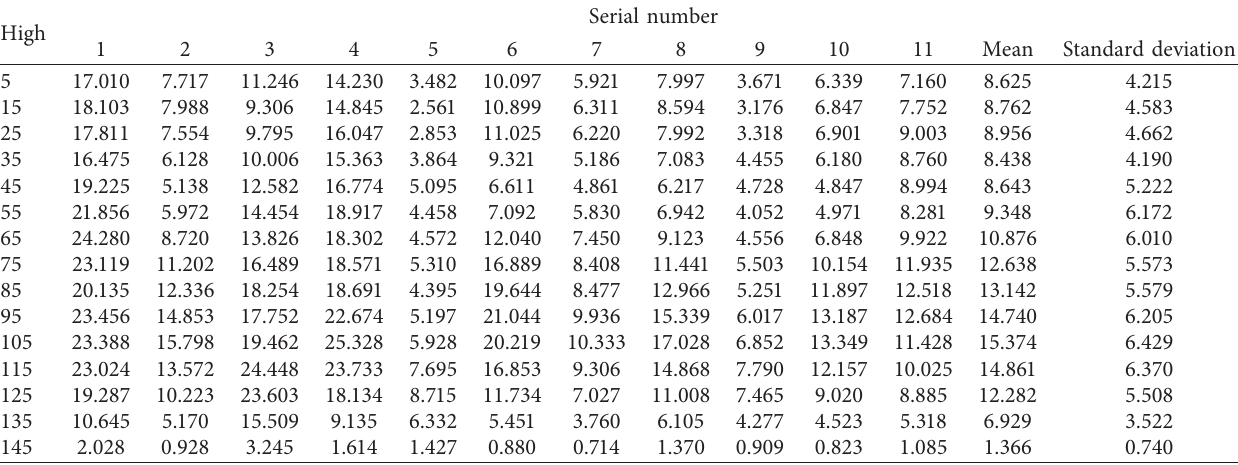
Table 5: Maximum earthquake compressive stresses of the 150m high chimney under the action of 11 earthquake waves considering vertical eccentricities.